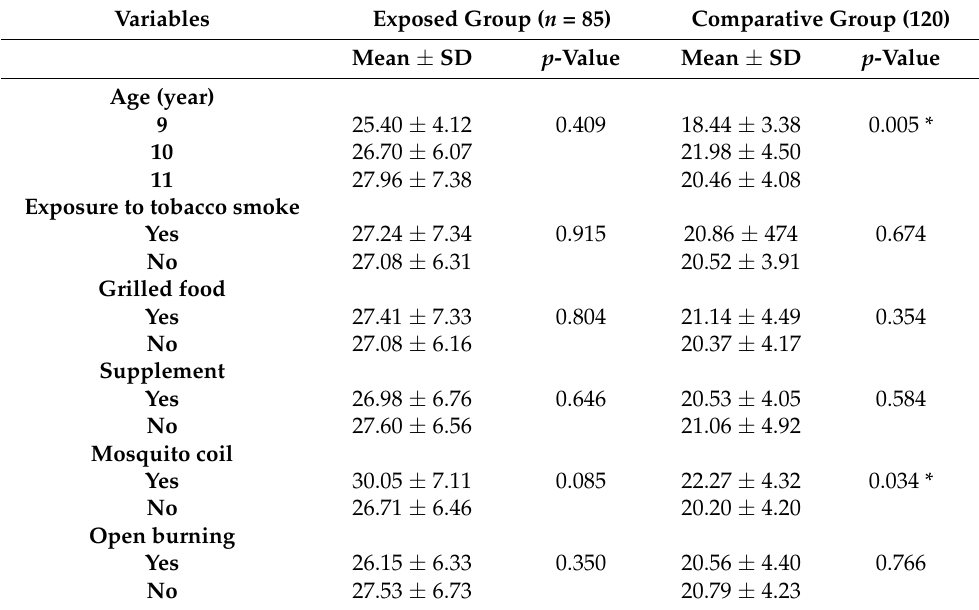
Table 3. Comparison of individual factors in the tail moment among children. Variables Exposed Group ( n = 85) Comparative Group (120) Mean ± SD p -Value Mean ± SD p